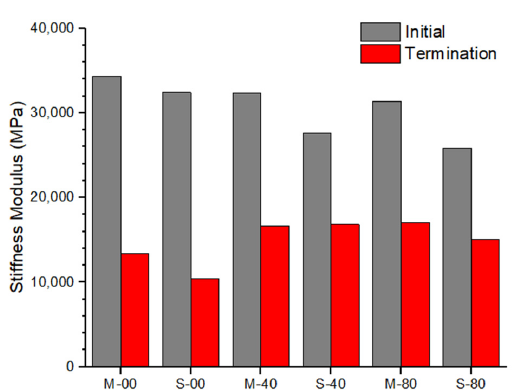
Figure 5. Stiffness modulus of the rigid pavement specimens at the start and the end of the 4PB fatigue tests.